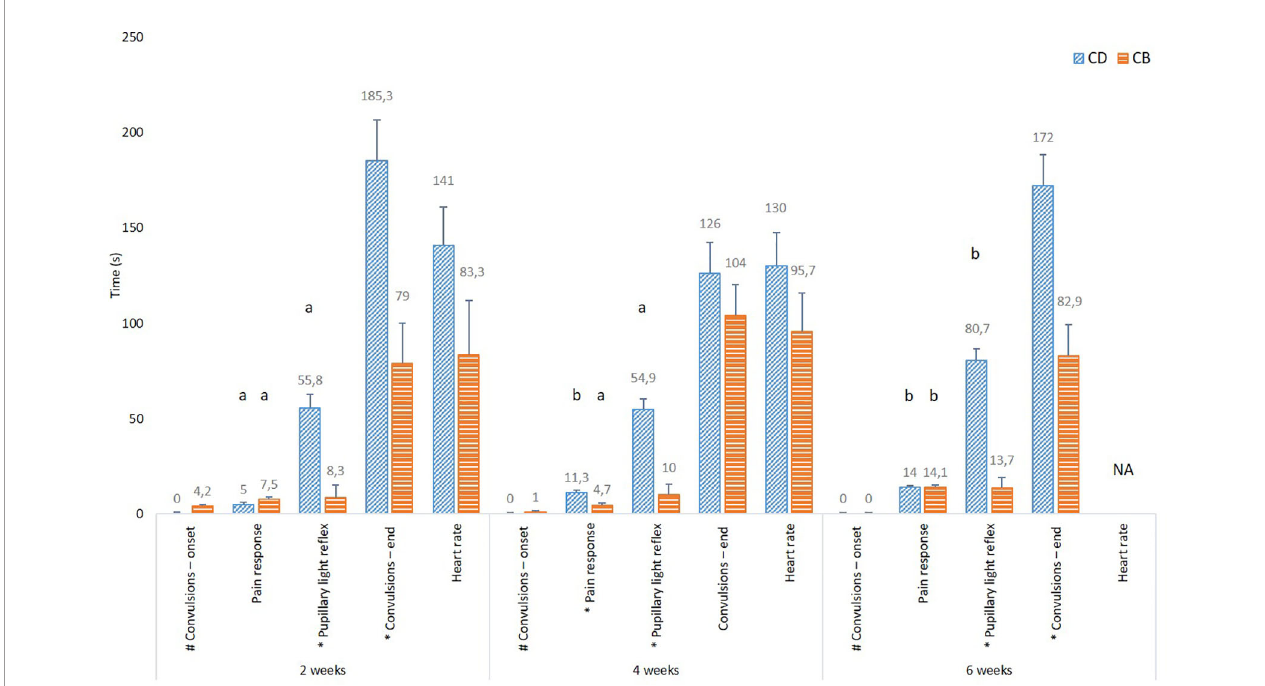
FIGURE 1 | Evaluation of two killing methods, manual cervical dislocation (CD) and captive bolt (CB) in broiler chickens of 2, 4, and 6 weeks old. Mean (SE) duration in s of onset (convulsions – onset) or cessation (pain response to comb pinch, pupillary light re fl ex, convulsions – end, heart rate) of non-invasive indicators. Time measurements started from the moment the killing manipulation was completed. * indicates signi fi cant difference observed for method within age ( P <0.001). a, b indicates signi fi cant differences observed for age within a method ( P <0.05). #, the results were not statistically analyzed as the indicator was not normally distributed and also non-parametric tests were not possible due to too similar values. NA, measurements of the heart rate were not possible at 6 weeks of age due to thickness of the breast muscles. Convulsion-onset and pain response are indicators for insensibility, convulsion-end is an indicator of brain death, whereas pupillary light re fl ex can be an indicator for both. Heart rate is an indicator of clinical